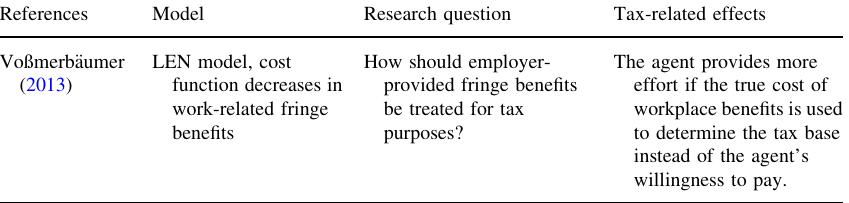
Table 7 Wage taxes, investment decisions and capital